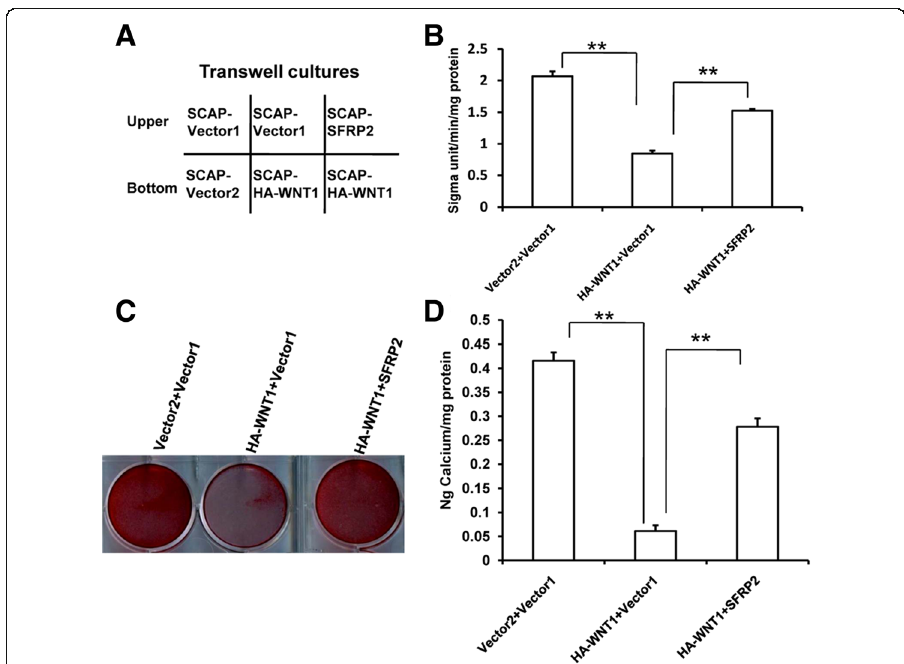
Fig. 6 SFRP2 rescued the impaired osteogenic differentiation potential of WNT1 in SCAPs. a Schematic representation of the transwell culture. b Transwell culture results showed that overexpression of SFRP2 could partially inhibit the reduction in ALP activity by WNT1. c Alizarin Red staining and ( d ) quantitative analysis of calcium concentration results showed that the overexpression of SFRP2 could partially inhibit the reduction in mineralization by WNT1. Vector 1: empty vector as the control of SFRP2. Vector2: empty vector as the control of HA-WNT1. Student ’ s t test was performed to determine statistical significance. All error bars represent SD ( n = 3). ** p ≤ 0.01. (sigma unit: unit of measurement for ALP